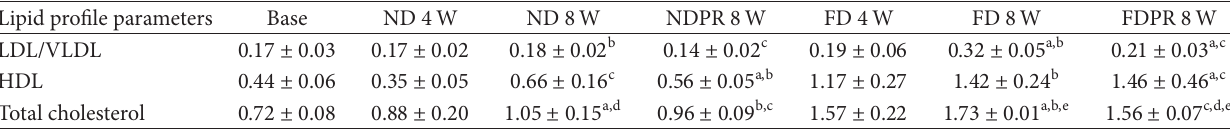
Table 1: Lipid profiles in mice fed normal diet (ND), high fat diet (FD), normal diet with probiotics (NDPR), and fat diet with probiotics (FDPR) at the start of the study (base) and at 4 and 8 weeks into the study (4 W and 8W). Provided values are the mean ± standard deviation. Similar superscripted letters demonstrate pairwise significant ( 𝑃 < 0.05 )